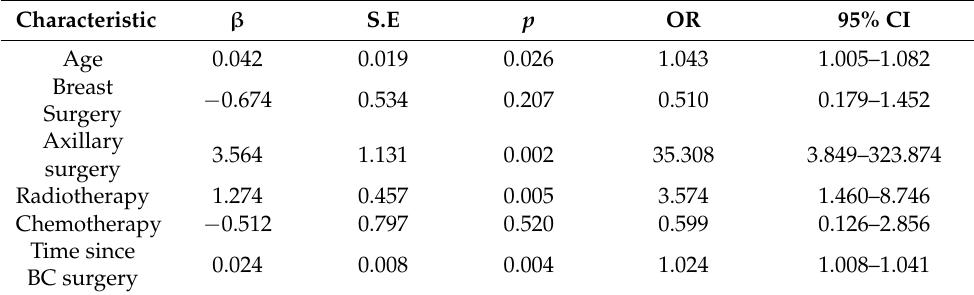
Table 2. Multivariable logistic regression of clinicopathologic data.